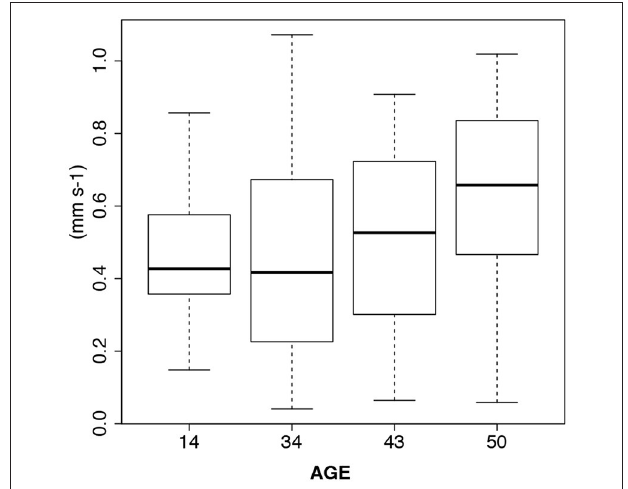
FIGURE 2 | Boxplots of L. pertusa larvae swimming velocity (mm s − 1 ) depending on age (days) in control treatments of the feeding experiments. There is no sign of senescence in the oldest age